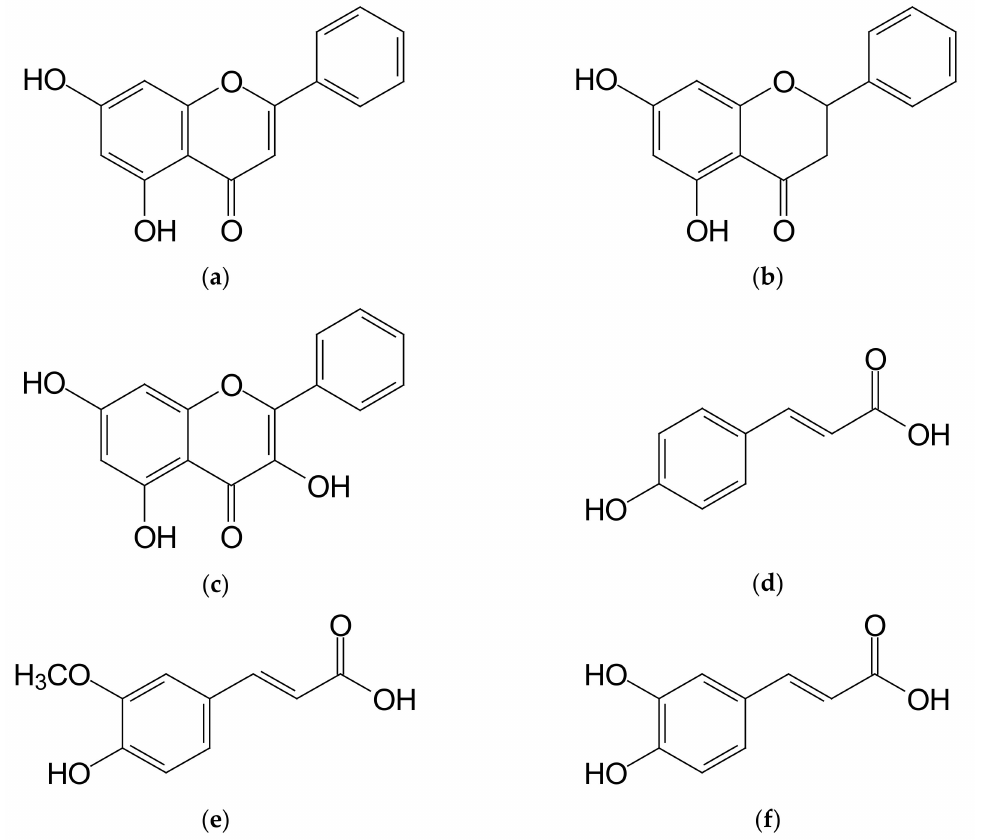
Figure 1. The main phenolic compounds determined in honey samples enriched with propolis. ( a ) Chrysin; ( b ) Pinocembrin; ( c ) Galangin; ( d ) p-Coumaric acid; ( e ) Ferulic acid; ( f ) Ca ff eic